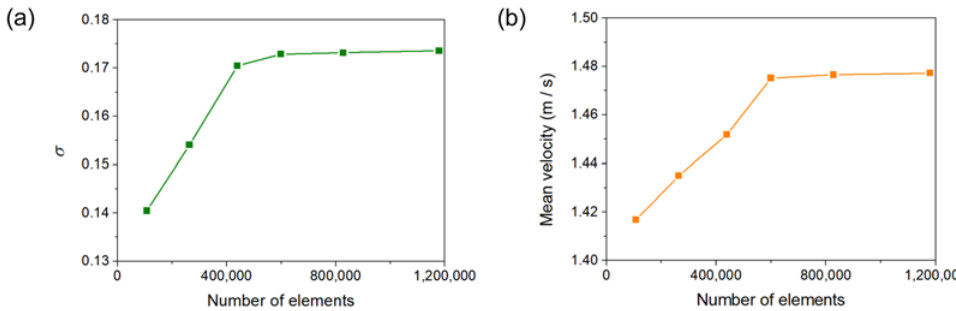
Figure 3. Grid independence test; ( a ) Effect of the number of elements on the relative standard deviation of particle concentration; ( b ) Effect of the number of elements on the mean velocity of the computational domain.